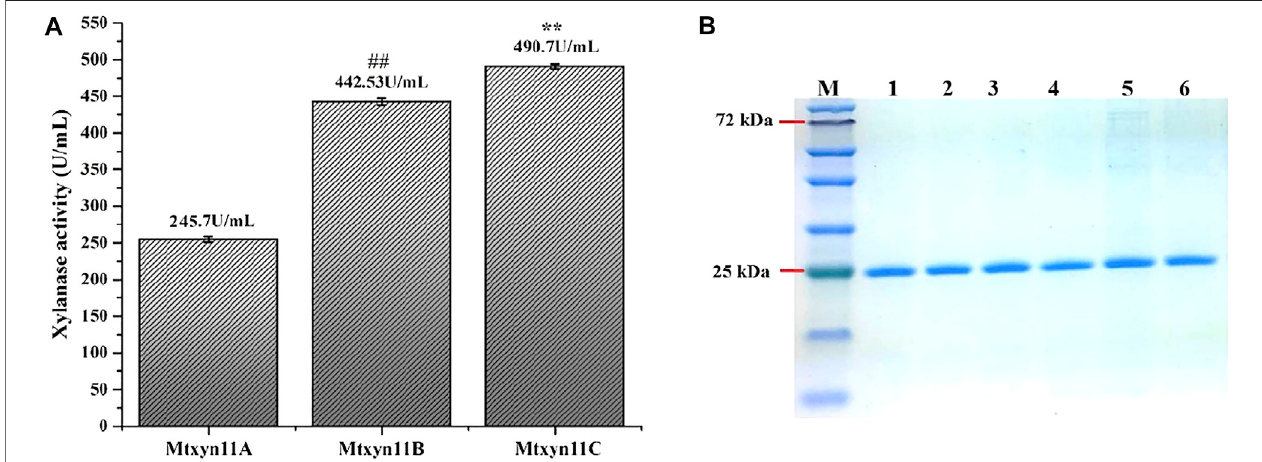
FIGURE 2 | Enzyme activities and SDS-PAGE analysis of the recombinant proteins. (A) Schematic representation of the xylanase activity of each recombinant protein. Data represent mean ± SD of the independent triplicates. ** and ## indicates p < 0.05; (B) SDS-PAGE analysis of the puri fi ed recombinant proteins. M: Marker; Lane 1 – 2: Mtxyn11A; Lane 3 – 4: Mtxyn11B; Lane 5 – 6: Mtxyn11C.